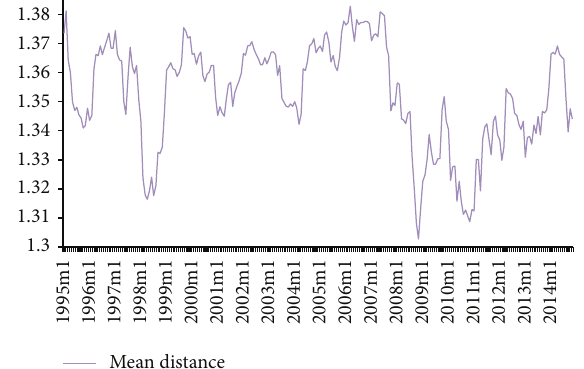
Figure 1: Normalized tree length as a function of 𝑇 . We used time windows of 𝑇 = 12 months and window step length parameter Δ𝑇 = 1 month.